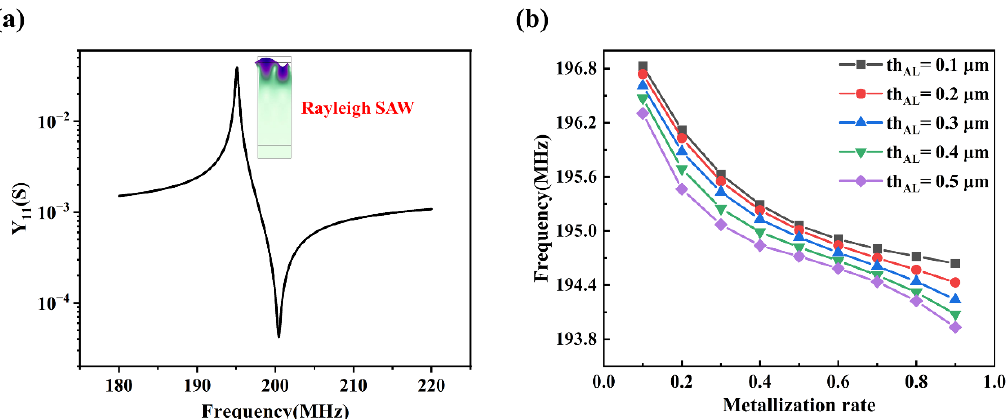
Figure 5. ( a ) The admittance curve of the simplified 2D model under initial structural parameters. ( b ) Variation curves of RSAW resonant frequencies with respect to metallization rates η and electrode thicknesses th Al .